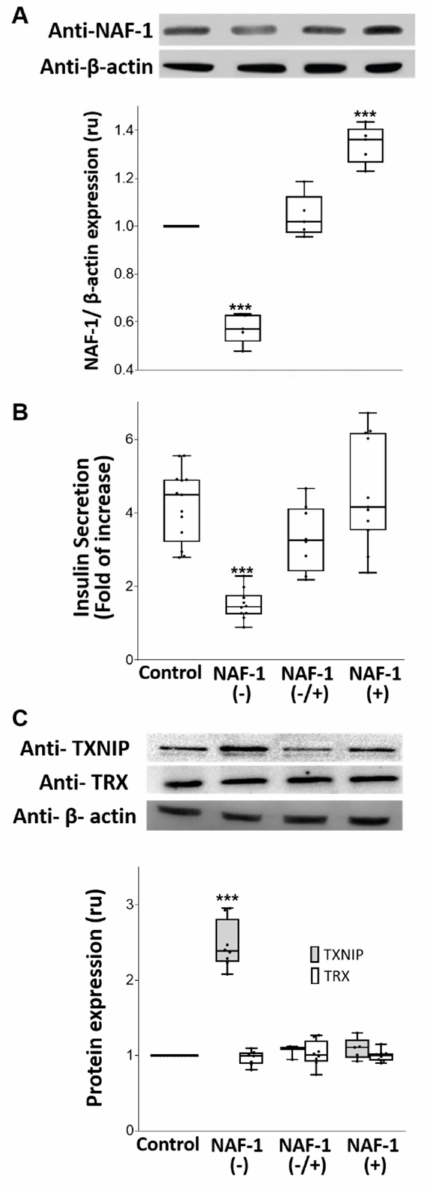
Figure 1. NAF-1 protein levels, insulin secretion, and TXNIP expression in INS-1E cells with repressed or overexpressed NAF-1 levels. ( A ) Protein blots (Top) and β -actin-normalized expression graph (Bottom) showing NAF-1 protein levels in control, NAF-1( − ), NAF-1( − /+), and NAF-1(+) cells. ( B ) Fold change in glucose-stimulated insulin secretion of INS-1E cells expressing different levels of NAF-1. ( C ) Protein blots (Top) and β -actin-normalized expression graph (Bottom) showing TXNIP and TRX protein levels in INS-1E cells expressing different levels of NAF-1. The results are presented as box-and-whisker plots and include all data points measured in three different experiments. *** p < 0.001, compared to control; Student’s t -test, N = 3. Abbreviations: TRX, Thioredoxin; TXNIP, Thioredoxin-interacting